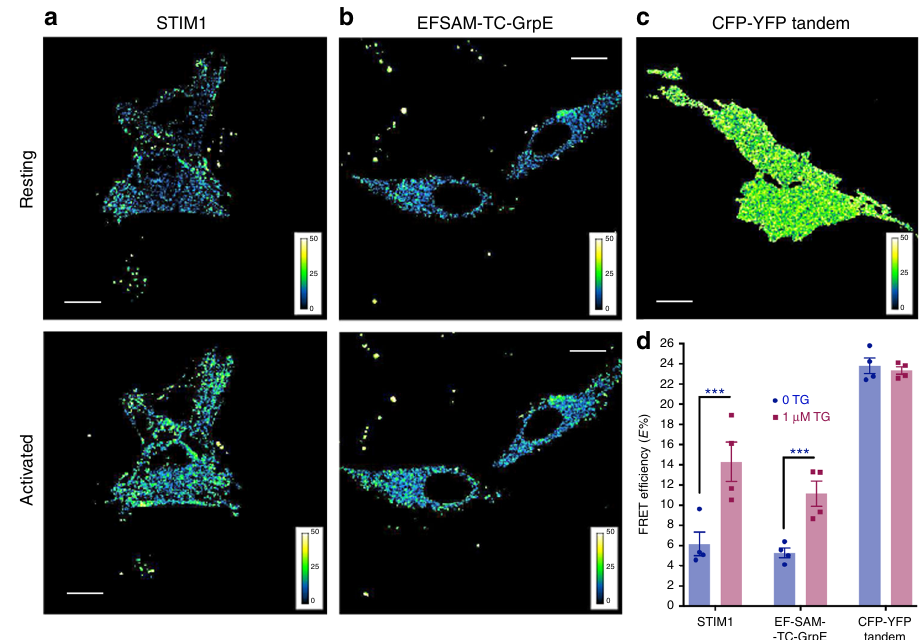
Fig. 2 Ca 2 + -dependent conformational change in cells. a – b Confocal micrographs showing FRET before (resting; upper panels) and after 1 μ M TG stimulation (activated; lower panels) in representative HeLa cells co-expressing CFP- and YFP-tagged full-length STIM1 ( a ; n = 7) or EFSAM-TC-GrpE ( b ; TC = STIM1 transmembrane and CC1 regions; n = 7). Scale bars, 5 μ m. False-color scale representing normalized FRET ef fi ciency, expNFRET, for each image is included as inset. c Confocal micrograph showing FRET in HeLa cells expressing a CFP-YFP tandem construct as a control, without TG treatment ( n = 5). Scale bar, 5 μ M. False-color scale representing normalized FRET ef fi ciency, expNFRET, is included as inset. d Quanti fi cation of FRET changes in a – c . Error bars report SEM. CFP-YFP FRET change in HeLa cells expressing either STIM1 or EFSAM-TC-GrpE was signi fi cant after treatment with 1 μ M TG (marked with ***, p < 0.05 by an unpaired, two-tailed Student ’ s t